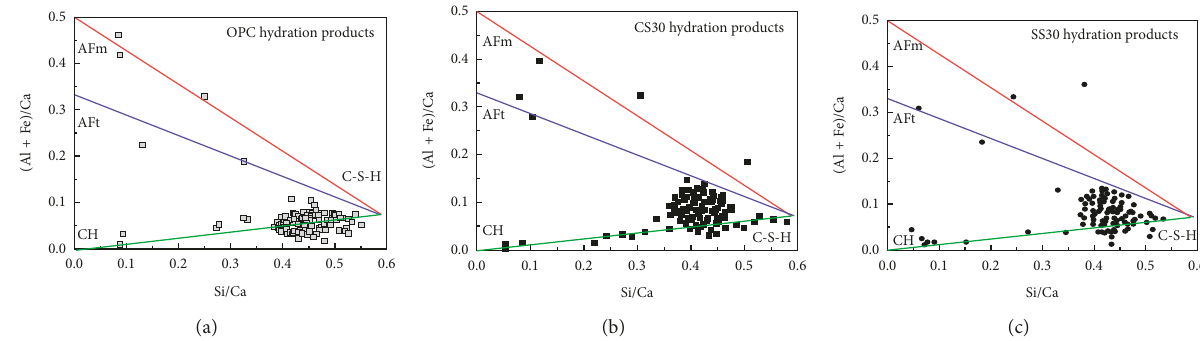
Figure 12: Si/Ca versus (Al + Fe)/Ca atom ratio plots of SEM-EDX analyses of the hydration products present in (a) OPC, (b) CS30, and (c)